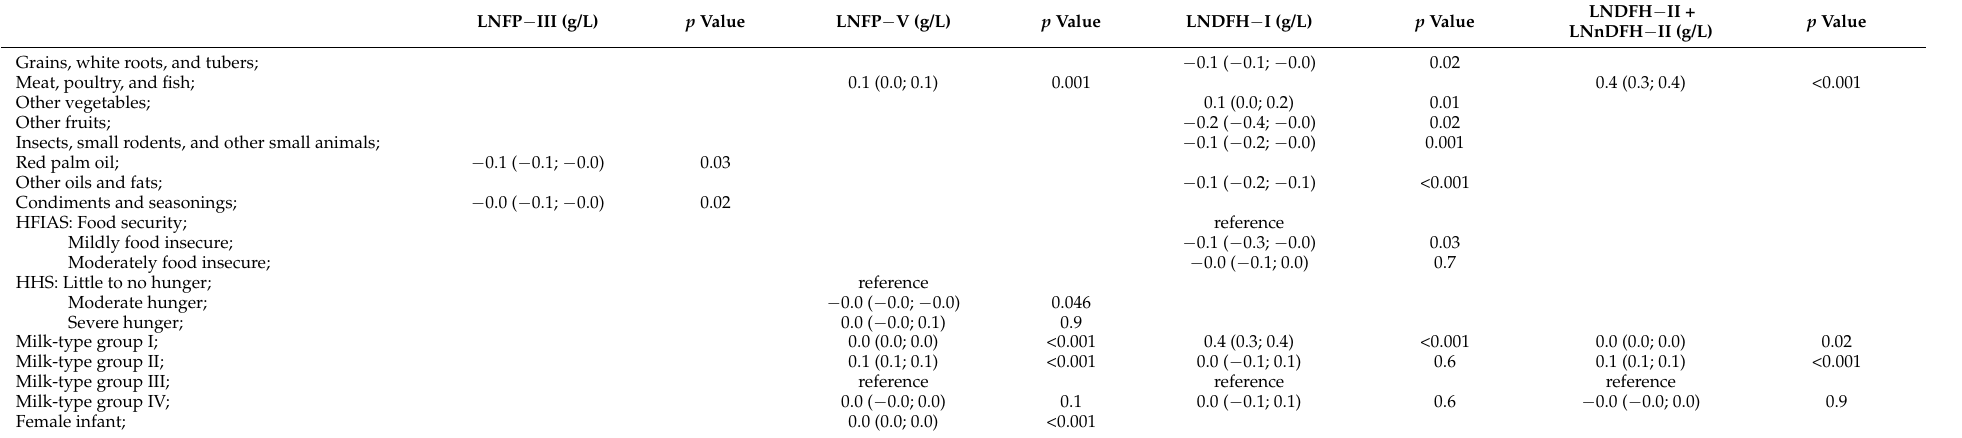
Table 4. Multilevel models of the dietary determinants of human milk oligosaccharide levels during the first 6 months of life (3). LNFP − III